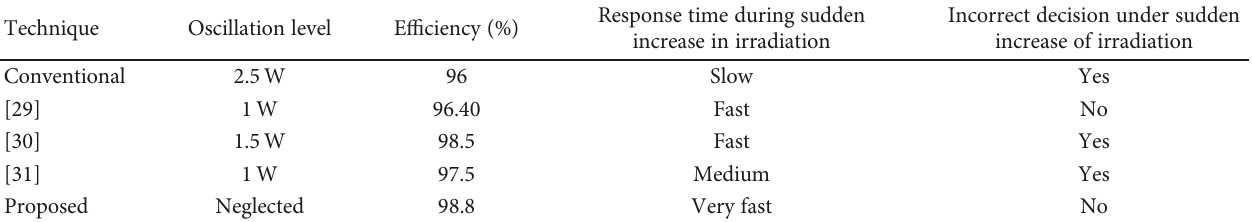
Table 3: Comparison of the proposed algorithm with other improved incremental conductance algorithms proposed in scienti fi c literature. Technique Oscillation